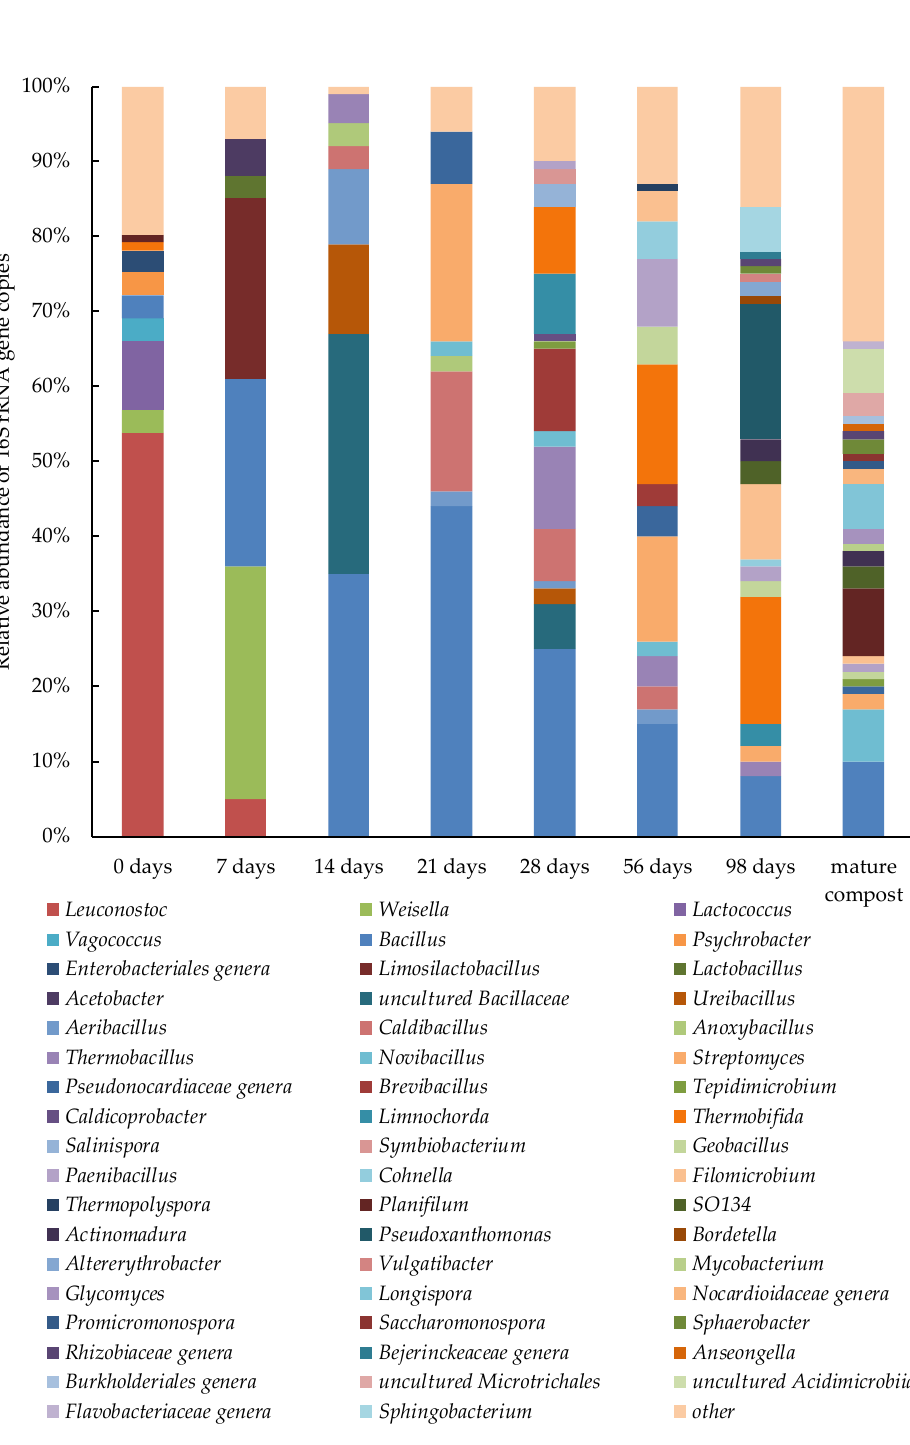
Figure 6. Genus-level composition of the prokaryotic community (genera or higher prokaryotic taxa that constituted more than 1% of the prokaryotic community are represented; the rest are grouped under the name “other”).